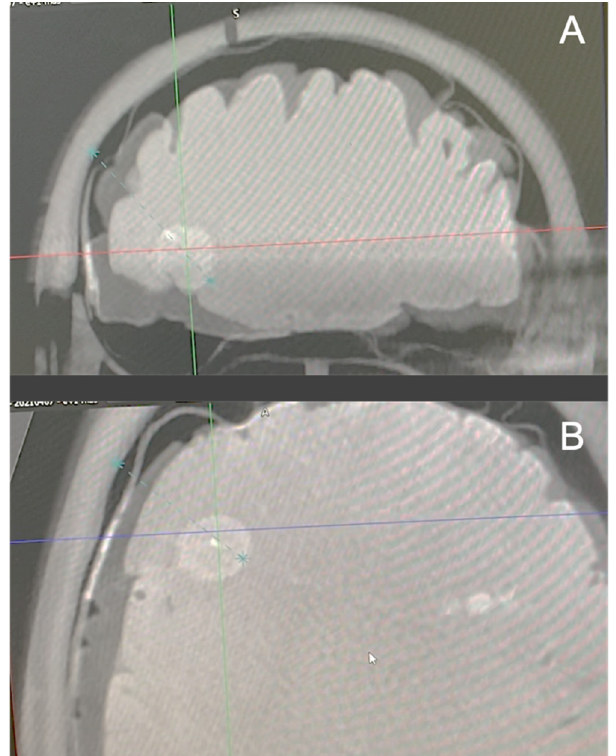
Figure 6. A CBCT (O-Arm, Medtronic) was performed after the insertion of the optical fiber through its guide. The planned trajectory is the dotted blue line. The optical fiber appears in white. As the optical fiber is superposed to the blue line, and the accuracy was estimated as satisfying. ( A ) Coronal plane. ( B ) Axial plane.